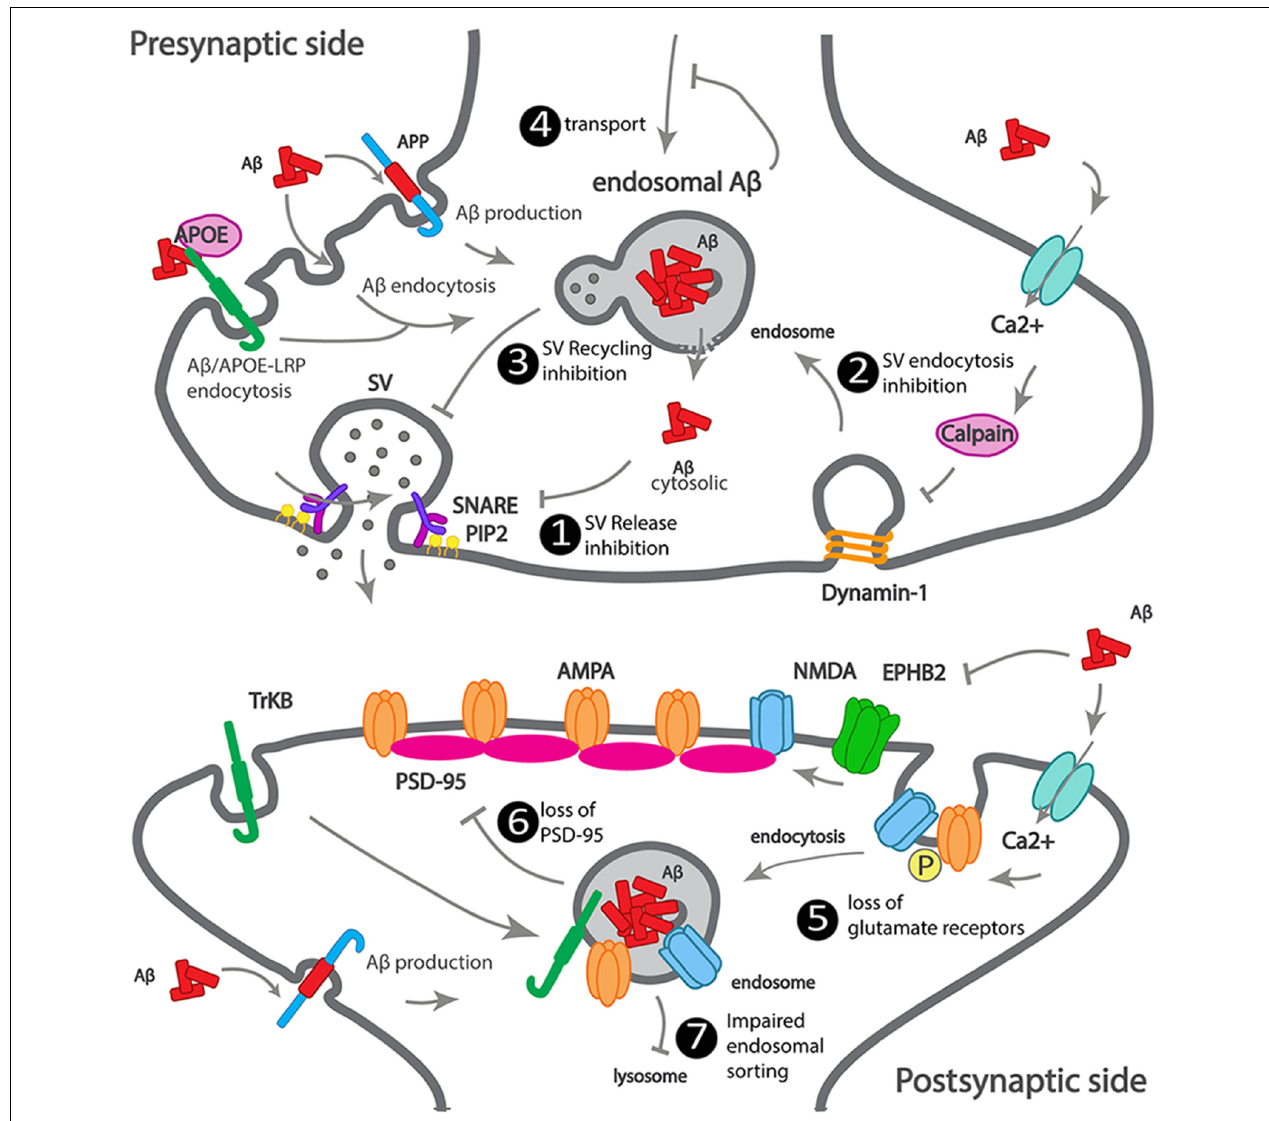
FIGURE 2 | Scheme illustrating how A β impacts synaptic trafficking. Scheme of a dysfunctional early-onset familial AD (eFAD) synapse. At the presynaptic terminal: 1. Synaptic vesicle release inhibition, extracellular A β endocytosed, alone or via ApoE-LRP endocytosis can accumulate at endosomes. Intracellular A β , produced from APP endocytosis, accumulates at endosomes. Endosomal A β can disrupt the endosomal membrane and reach the cytosol, where it can potentially bind to SNARE subunit syntaxin-1a, or indirectly inhibit synaptophysin or PIP2, thus inhibiting synaptic vesicles (SV) fusion and neurotransmitter release. 2. SV endocytosis inhibition, extracellular A β increases calcium influx, triggers calcium-dependent calpain to degrade dynamin1, reducing endocytosis. 3. SV recycling inhibition by intracellular A β . 4. Transport to synapses inhibition by intracellular A β oligomerization. At the postsynaptic terminal: 5. Increased endocytosis of AMPA and NMDA receptors, by intracellular and extracellular A β . 6. Loss of PSD-95 by intracellular A β . 7. Impaired endosomal sorting of TrkB receptor, by endosomal A β .